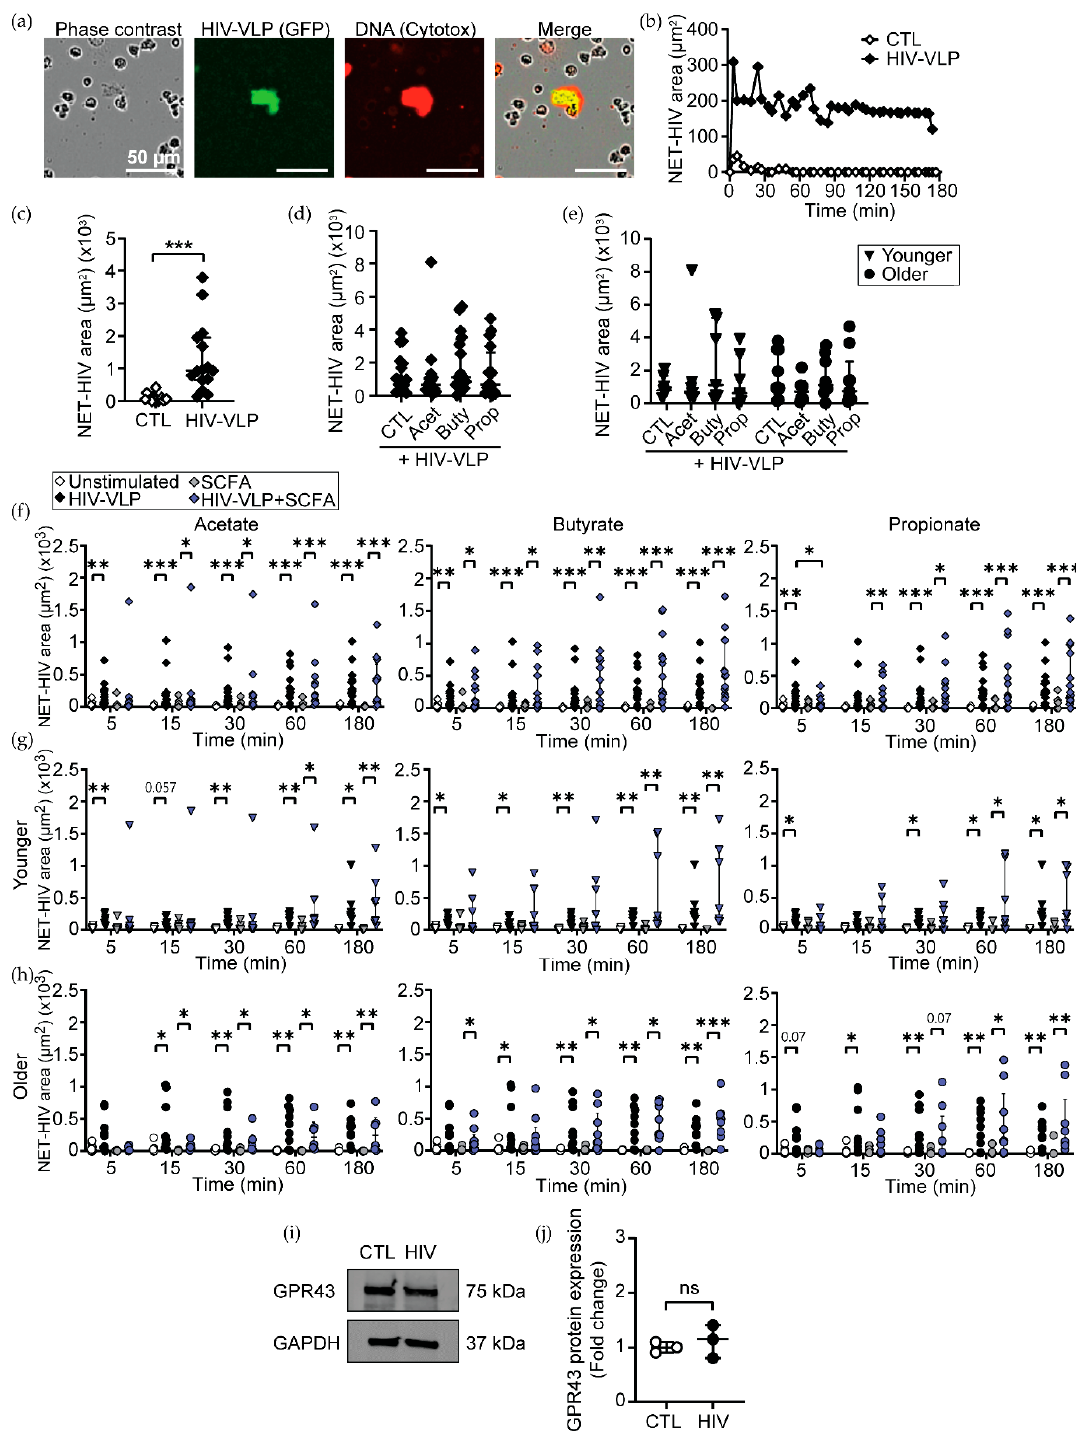
Figure 5. Pathological concentrations of SCFA induce a significant delay in HIV-induced NET release by neutrophils. ( a ) Representative image of NET formation and co-localization with HIV-VLPs, quantified with IncuCyte S3 system. ( b ) Total NET-HIV area of unstimulated controls (white dots) and HIV-VLP (black dots) is represented over time. ( c ) Quantification of HIV-NET area in the first 3 h and ( d ) after treatment with 25 mM of acetate, butyrate or propionate after stimulation with HIV-VLPs ( n = 16). ( e ) Effect of age on NET release by SCFA-treated neutrophils. ( f ) Comparison of HIV-induced NET release by time intervals in all women ( n = 16) and separated in ( g ) younger ( n =